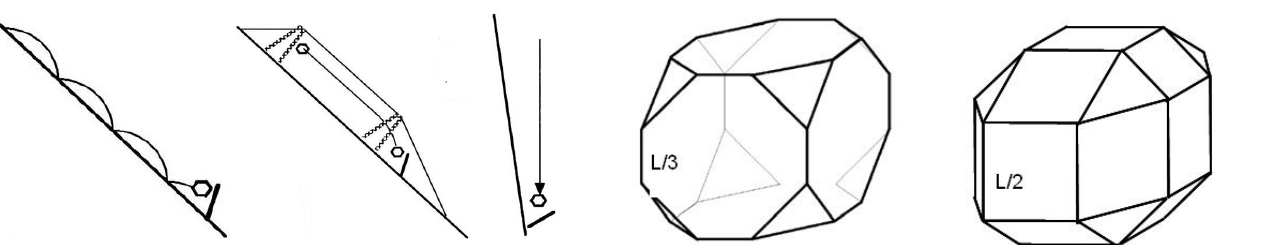
Fig. 21. Standardized test blocks for flexible rockfall protection systems related to a regular cube with edge length L according to the approval guidelines of Switzerland (left, Gerber, 2001a, until 2008) and the European Union (right, EOTA, 2008).